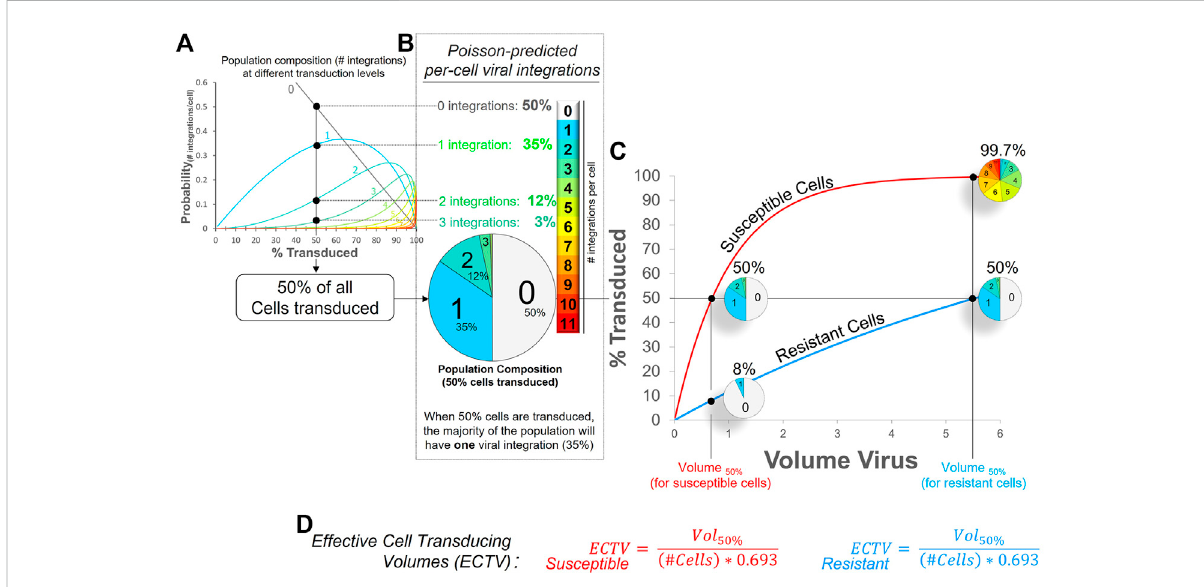
FIGURE 2 Essence of lentiviral transductions and ECTV calculation. (A) Poisson mass distribution function: Shown is the predicted relationship between overalltransductionef fi ciency(%cellstransduced)andtheexpectedcellfractionscontainingbetweenoneandelevenviralintegrations(lightblueto redtraces). (B) Piechartillustrating,when50%ofallcellsinapopulationaretransduced,thepredictedproportionofcellsinthatpopulationthathave zero, one, two, or three viral integrations (per cell). (C) Poisson-predicted viral transduction of two cell types displaying an 8-fold difference in viral susceptibility. Without a method to balance transductions between coexisting cell types, susceptible cells will always, at all viral doses, have 8× more viral integrations than the resistant cells, as illustrated by the small pie charts. (D) The volume of virus stock required to achieve a de fi ned transduction level can be predicted by determining the respective ECTV (Effective Cell Transducing Volume) for each cell type. At 50% transduction ef fi ciency, the ECTV is de fi ned by the volume of viral stock (that produced 50% cell transduction, Vol 50% ), divided by the product of the number of cells and the natural log of 0.5, i.e., (# cells × 0.693). For example, if 0.8 ul of virus was required to transduce 50% of 100,000 cells, the ECTV for this celltype(undertheseconditions)calculatesto0.8ul/-(100,000*ln0.5);whichis11.54picoliters(pL).OncethisECTVisknown,onecanmorereliably predict the amount of virus required to transduce a different fraction of cells; e.g., transducing 85% of cells under the same conditions will require 2.19 ul of virus stock (11.54 E − 6